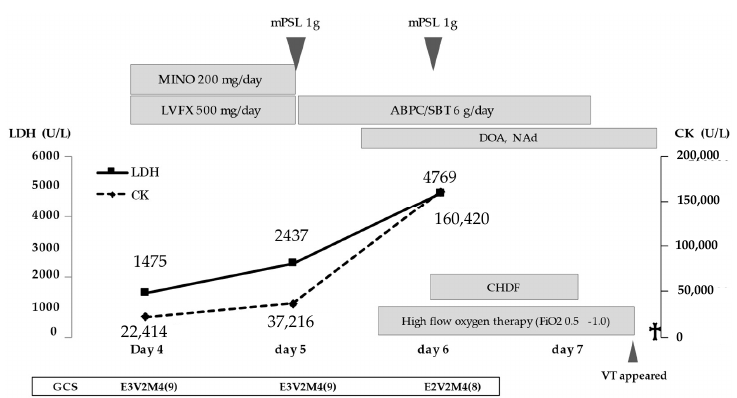
Figure 3. Clinical course: mPSL, methylprednisolone; MINO, minocycline; LVFX, levofloxacine; ABPC/SBT, ampicillin/sulbactam; DOA, dopamine; NAd, Noradrenaline; CK, creatine kinase; LDH, lactate dehydrogenase; CHDF, continuous hemodiafiltration; FiO2, fractional inspired oxygen concentration; GCS, Glasgow coma scale; VT, ventricular tachycardia; ♰ : died. An autopsy was performed six hours after his death. Gross pathological findings revealed a subcutaneous hemorrhage within prothorax regions, bilateral inguinal regions, and bilateral thigh regions. Histopathological examination revealed microscopic bleeding in multiple tissues such as skin, lungs, gastrointestinal mucosa, and thyroid and parathyroid glands. There was a marked hemophagocytosis in the bone marrow (Figure 4A). The left inguinal lymph node had lost its normal structure and presented with severe necrotizing lymphadenitis with infiltration of histiocytes and large-sized blastoid cells (Figure 4B,C). Immunohistochemistry (IHC) using an anti-SFTSV – nucleoprotein (SFTSV – NP) antibody, which was stained and analyzed by the National Institute of Infectious Diseases, revealed SFTSV – NP positive cells within the inguinal lymph node (Figure 4D), spleen, and bone marrow. Histologically, no SFTSV infection was found in the parenchymal cells of the heart and brain tissue. In gross histological findings from the myocardium, concentric left ventricular hypertrophy was observed, which was considered to be a finding of hypertensive heart disease. There were no histopathological findings suggestive of pericarditis and ischemic heart disease. The cardiac conduction system had also been preserved. Moreover, the presence of right atrial dilatation, hepatic and splenic congestion suggested right-sided heart failure. Histologically, infiltration of inflammatory cells was not apparent, and no myocarditis was observed. The trachea and bronchus were covered with pseudomembranous tissue (Figure 5A), which was accompanied by fungal infiltration.